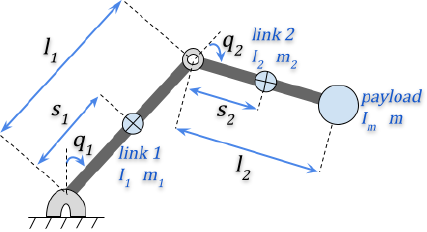
Figure 2. Schematics of SEIKO Instruments TT-3000 robot with attached